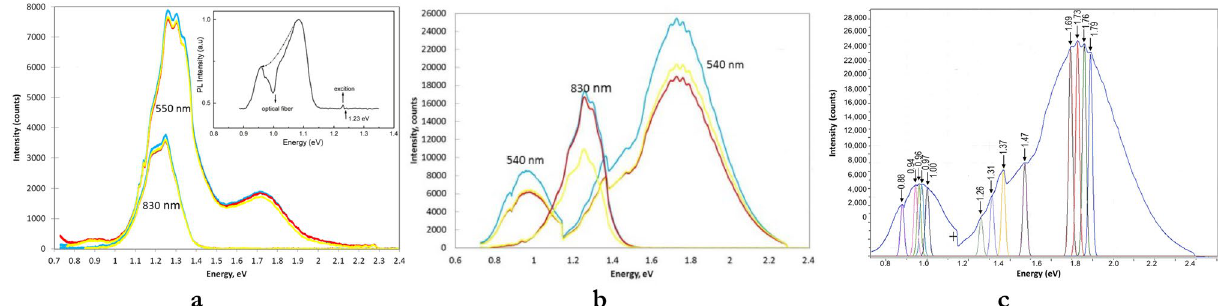
Figure 2. PL spectra using 532 nm laser with 830 and 540 nm filters for T (blue) and M (red) B (yellow) sections of ( a ) CISe S1, (inset) PL of CuIn 3 Se 5 crystal, Ref 14 ; ( b ) CISe S2; and ( c ) CLS peak analysis for CISe S2( T